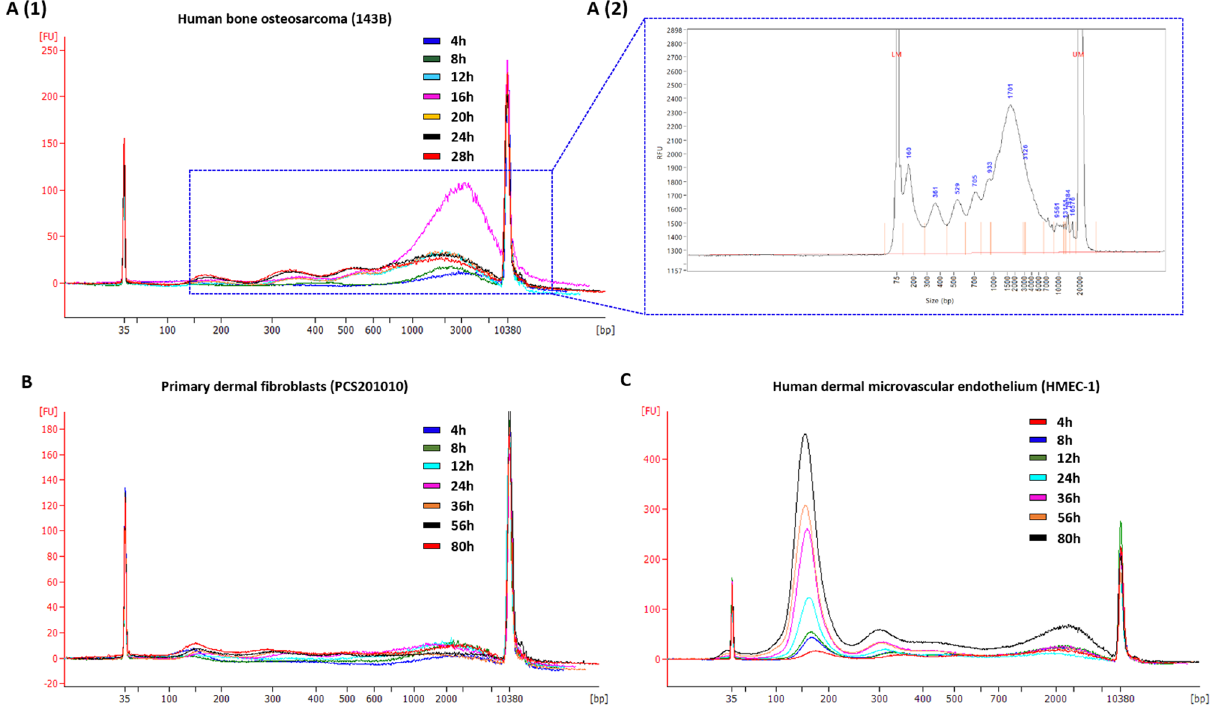
Figure 5. Cell-free DNA was isolated directly from cell culture supernatants and subject to size analysis. Electropherograms, generated with an Agilent Bioanalyzer, illustrates the cell-free DNA (cfDNA) size profiles at each time-point in cell culture supernatants from ( A ) human bone osteosarcoma (143B), ( B ) primary dermal fibroblast (PCS201010), and ( C ) human dermal microvascular endothelial (HMEC-1) cell lines. Electropherogram A (2) shows a 143B DNA size profile obtained when performing cfDNA size profiling using the dsDNA 930 Reagent kit on the Agilent Fragment Analyzer system, which allows higher resolution separation of DNA fragments in the range of 75 and 20,000 base pairs. The peaks at 35 and 10,000 bp correspond to the two internal size markers. The relative fluorescence (y-axis) of these markers is used to calculate the size of the unknown cfDNA samples (x-axis). Additional details of the cfDNA size analyses are summarized in Table